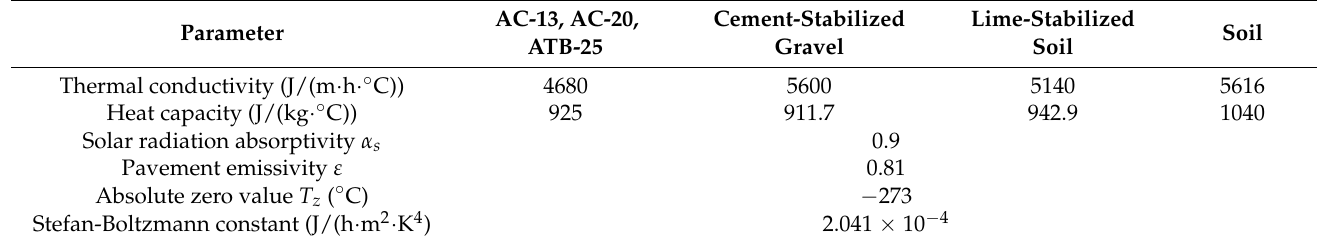
Table 2. Thermal property parameters of asphalt pavement structure